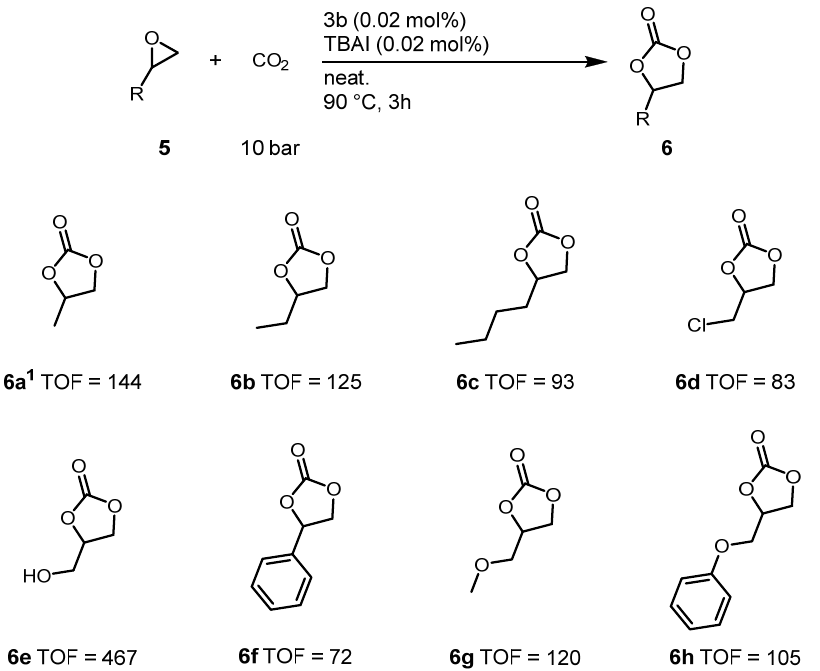
Figure 6. Scopes of epoxides. Reaction conditions: Epoxide (47 mmol), CO 2 (10 bar), Catalyst (10 mg,